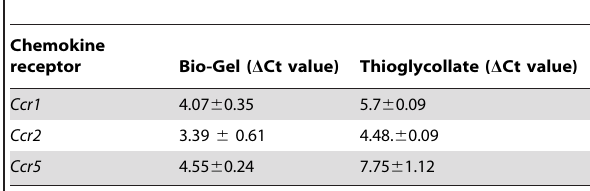
Table 2. Chemokine receptor mRNA expression in Bio-Gel and thioglycollate elicited